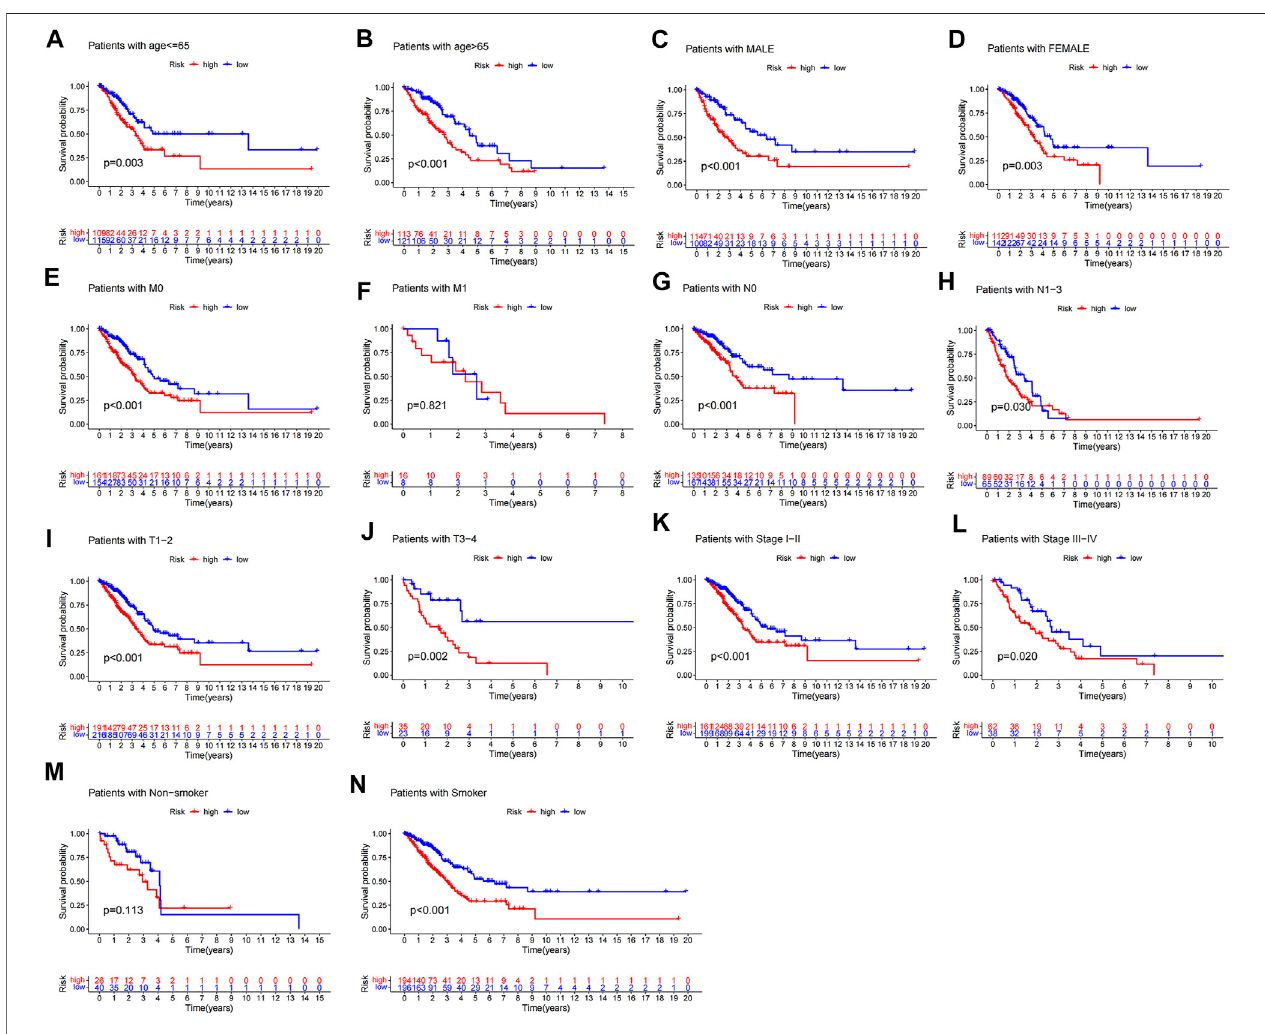
FIGURE 9 | Strati fi cation analysis of survival according to clinicopathological characteristics. (A,B) Survival analysis of all patients adjusted to age, (C,D) sex, (E,F) M stage, (G,H) N stage, (I,J) T stage, (K,L) pathological stage, and (M,N) somoking between high and low-risk groups.